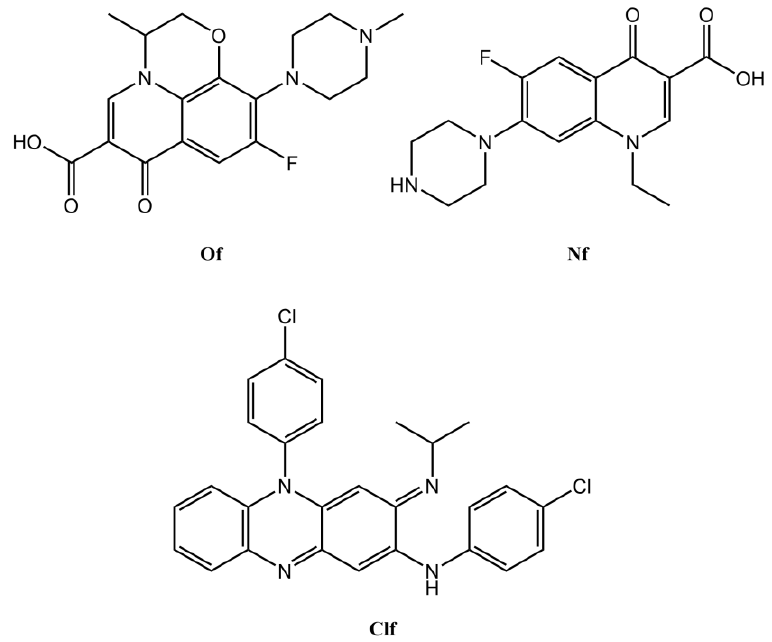
Figure 1. Structural formulae of the fluoroquinolones ofloxacin (Of) and norfloxacin (Nf), and of the antimycobacterial drug clofazimine (Clf).